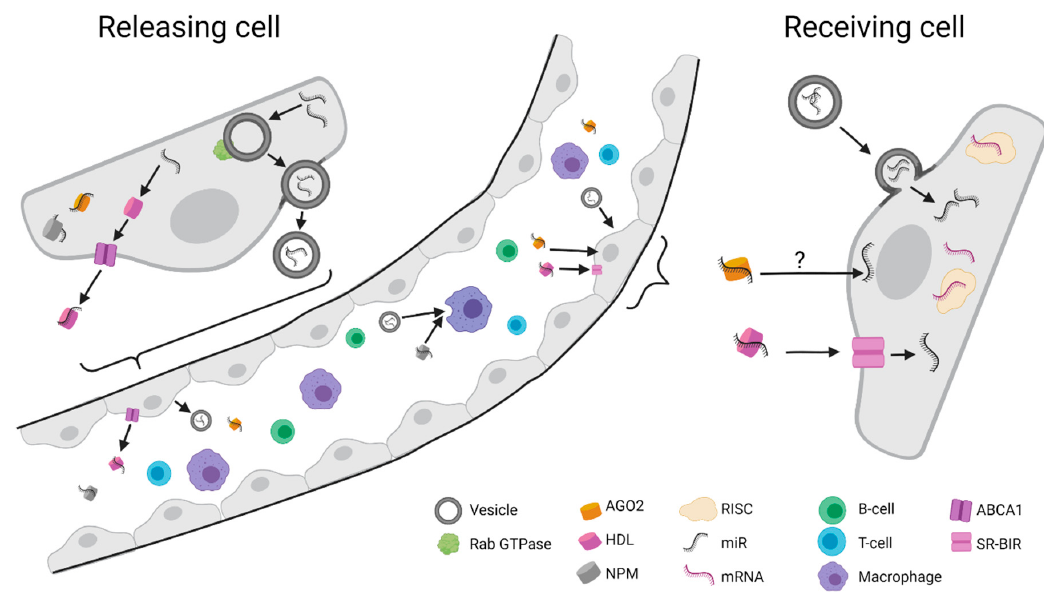
Figure 1. Exemplary transmission of miRNA from donor to acceptor cell: Secretion of miRNAs through complexing with argonaute-2 (AGO2), nucleophosmin (NPM), and high-density lipoprotein (HDL) and through phospholipid-transporting ATPase ABCA1. Microvesicles are released through external budding and plasma membrane fission in association with Rab GTPase and may carry sugars, lipids, protein, DNA, mRNA, and miRNAs. The uptake of HDL-conjugated miRNAs is mediated through HDL-(scavenger)-receptor (SR-BI). The internalization mechanism of AGO2 and NPM conjugates remains unclear. Microvesicles may transmit their load cell-type-dependently via plasma membrane fusion (merging) or endocytosis (receptor-mediated), micropinocytosis (cell-drinking), and phagocytosis (active engulfment). Loading of miRNA to the RISC complex in the target cell will affect target downregulation through translational repression. Figure created with BioRender.com.